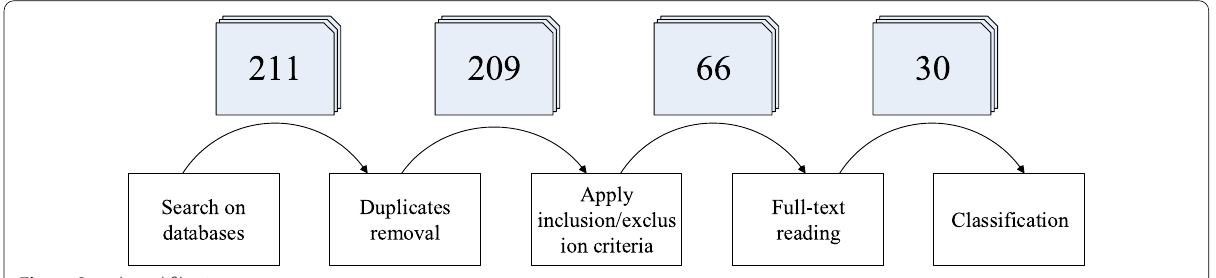
Fig. 1 Search and filtering